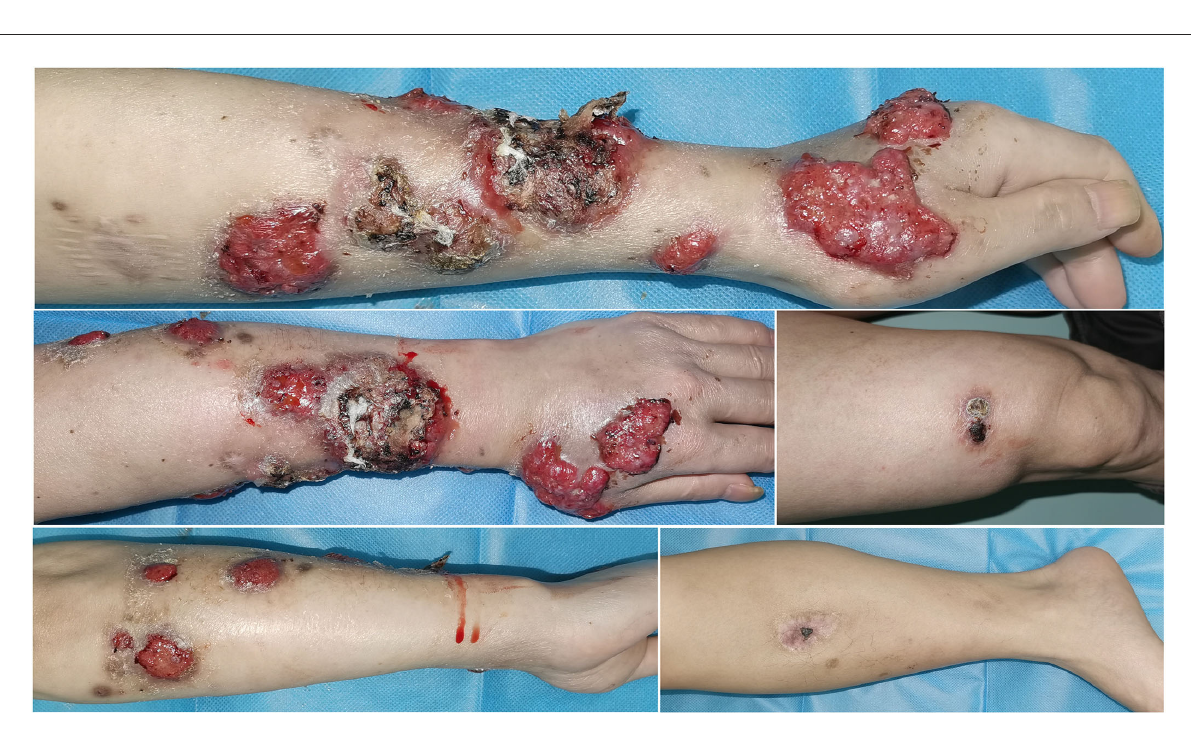
FIGURE3 After self-discontinuation of voriconazole, the existing lesions (verrucous and ulcerated nodules on the left upper limb, and papules and plaques on the right thigh) recurred and worsened, extending to the right leg with crusted